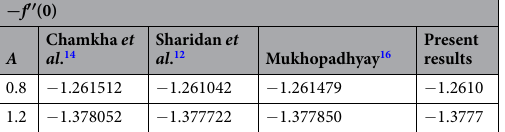
Table 1. Comparison of − ″ f (0) for different values of A with n = 1, β → ∞ and Bi → ∞ ,